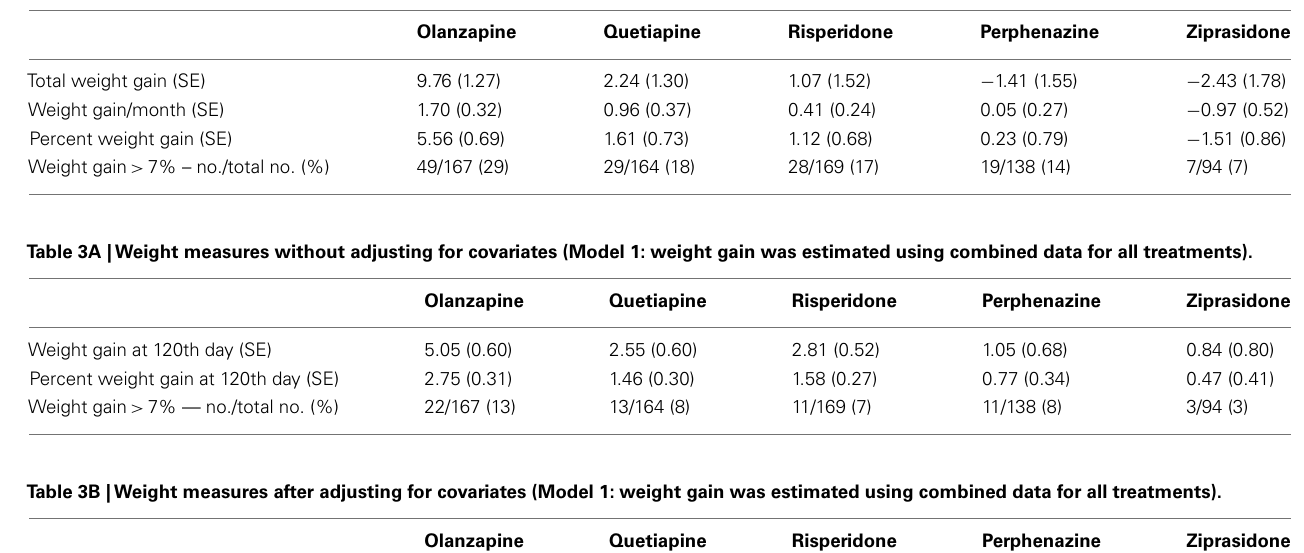
Table 2B |Weight measures after adjusting for covariates.